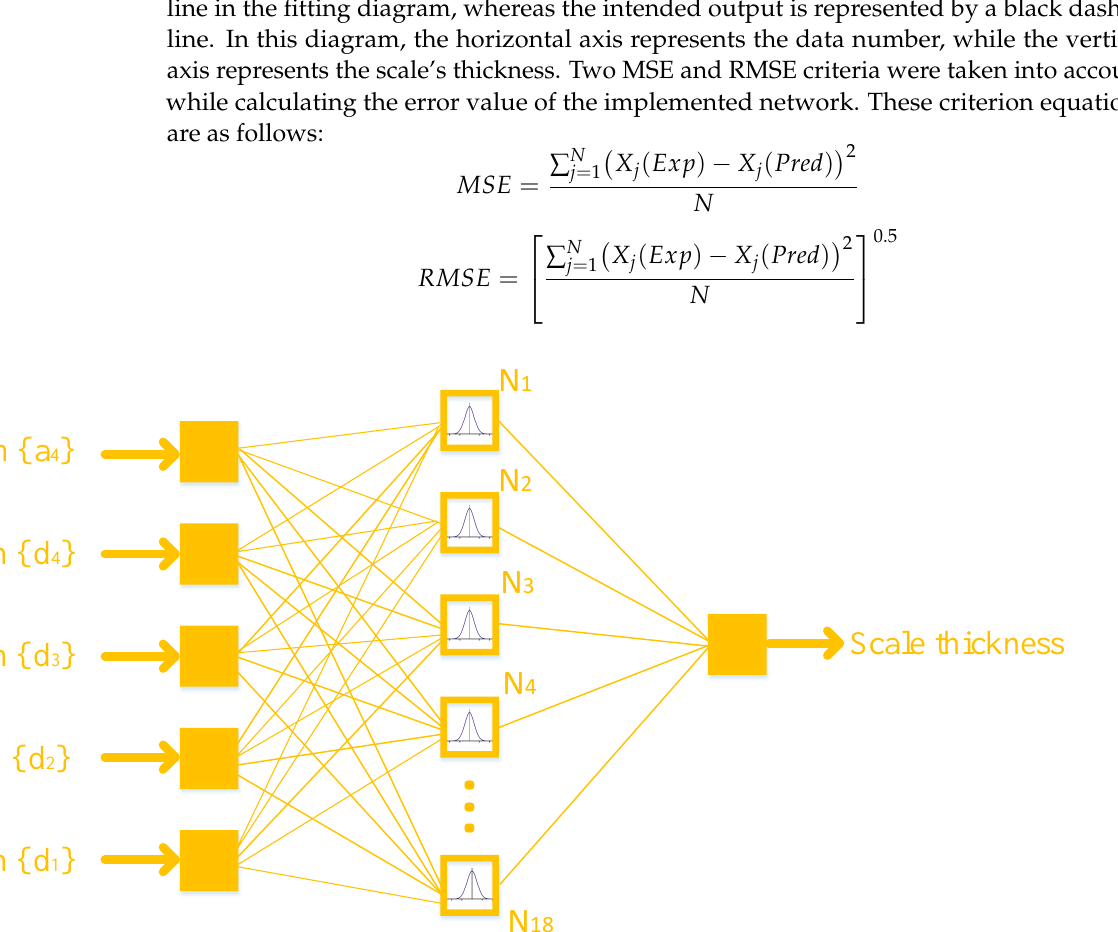
Figure 4. The architecture of the trained RBF neural network.